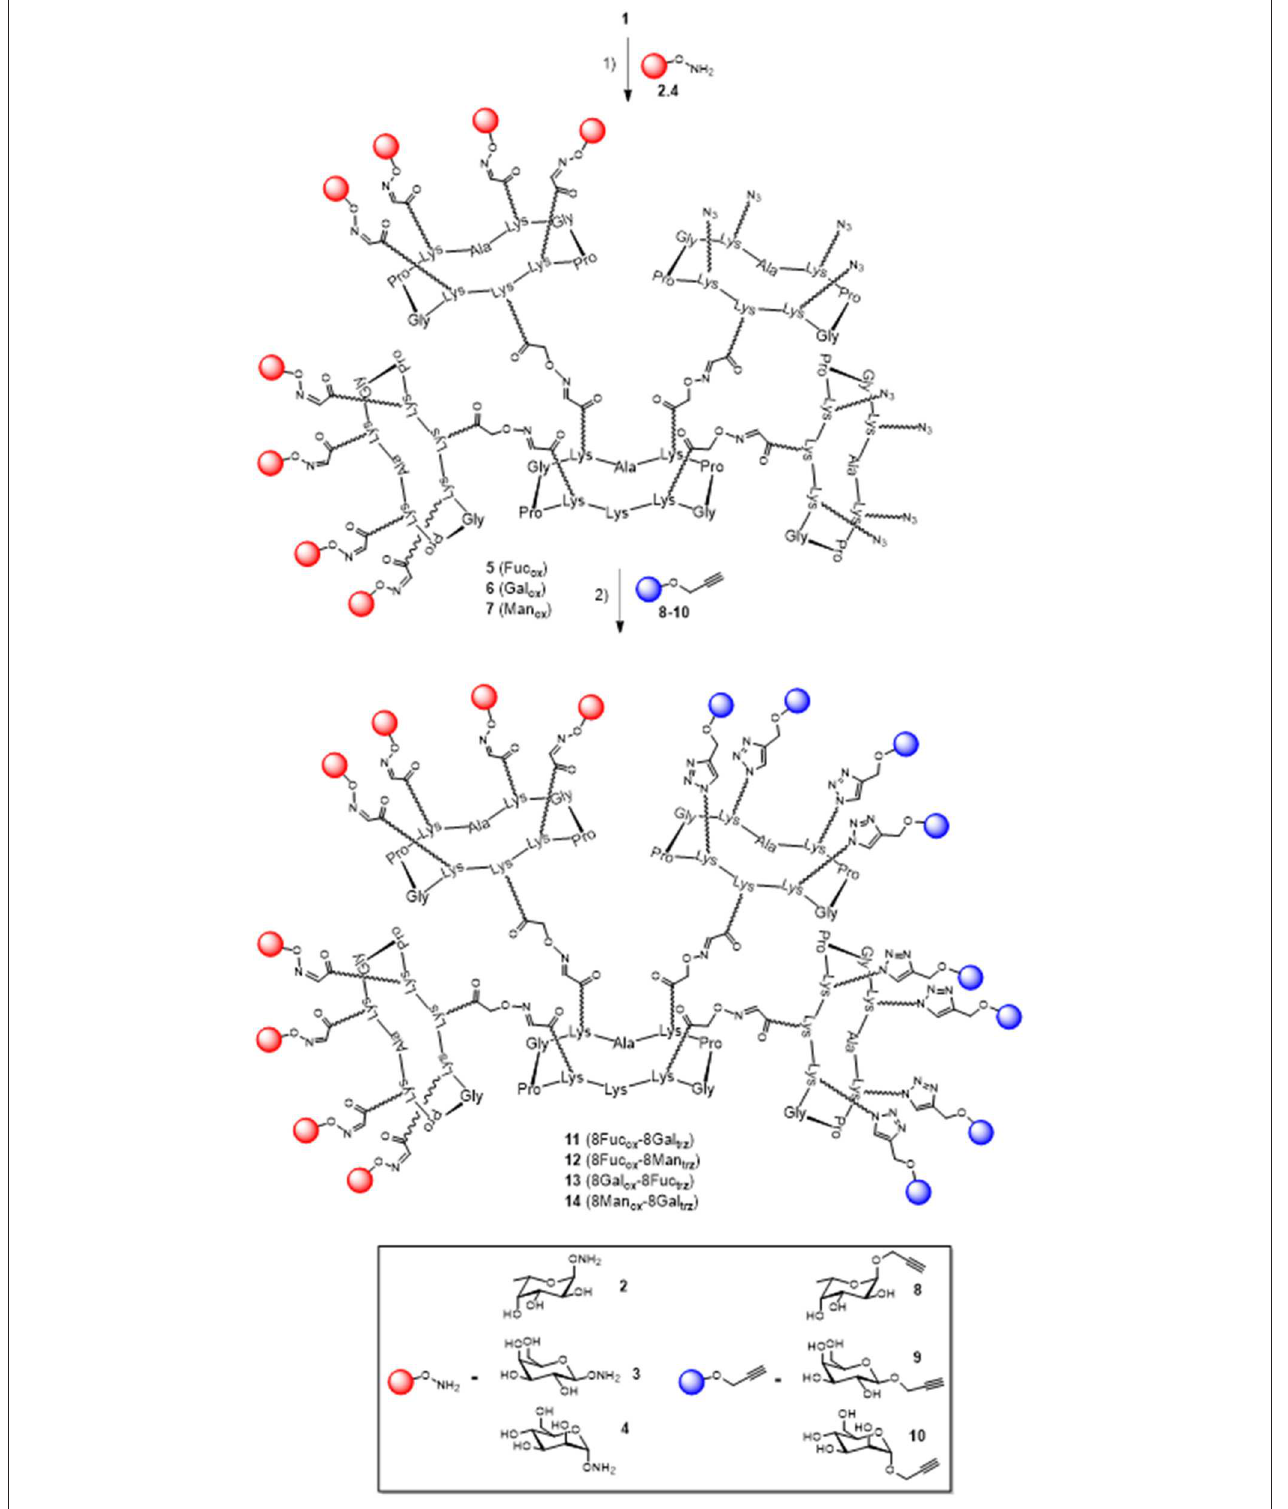
FIGURE 2 | Synthesis of hGCs 11 – 14 by a mixed OL and CuAAC strategy. Reagents and conditions: (1) 2 , 3 , or 4 , 0.1% TFA in H 2 O/CH 3 CN, 37 ◦ C, 30min; (2) 8 , 9 , or 10 , CuSO 4 , Na ascorbate, THPTA, PBS (pH 7.4, 10mM), r.t., 90min, 81% for 11 , 84% for 12 , 77% for 13 , and 76% for 14 .